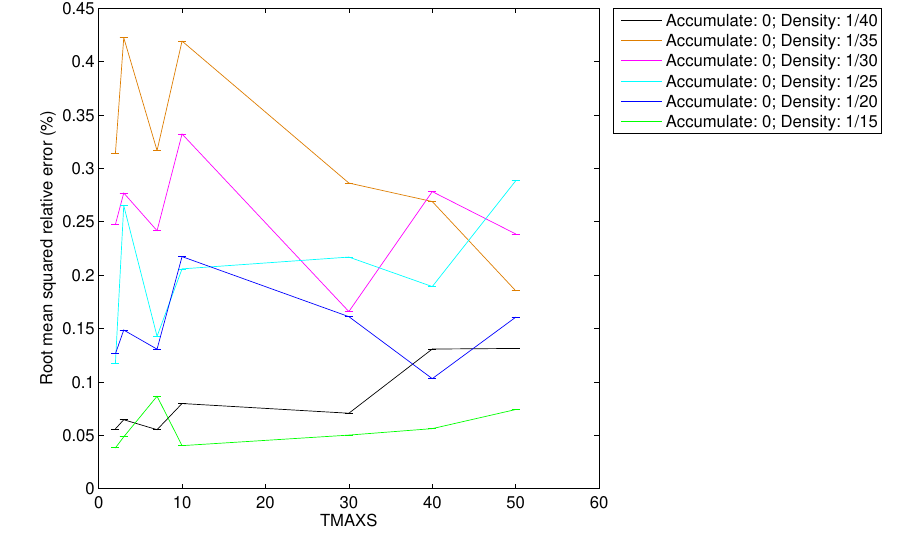
Figure 17. RMS relative error for